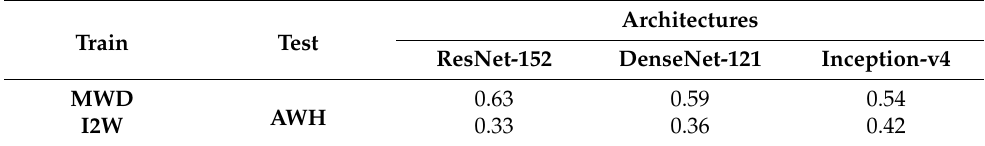
Table 9. Classification results of database transfer from public databases to Cerema-AWH with 3 meteorological classes. Architectures Train Test ResNet-152 DenseNet-121 Inception-v4 MWD AWH